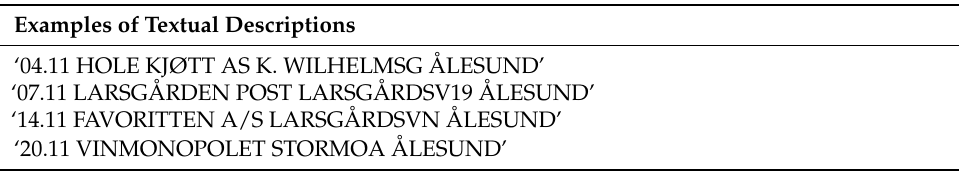
Table 2. Examples of textual descriptions of transaction data.